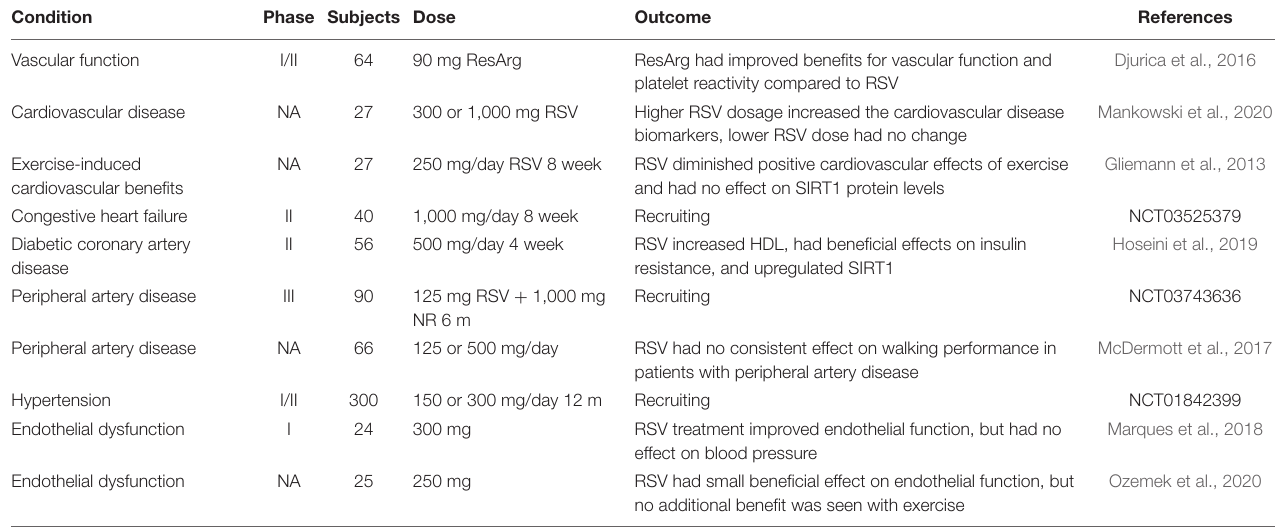
TABLE 3 | Resveratrol clinical trials for cardiovascular